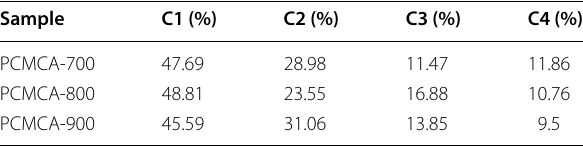
Table 2 XPS data of C 1 s composition of PCM-derived carbon